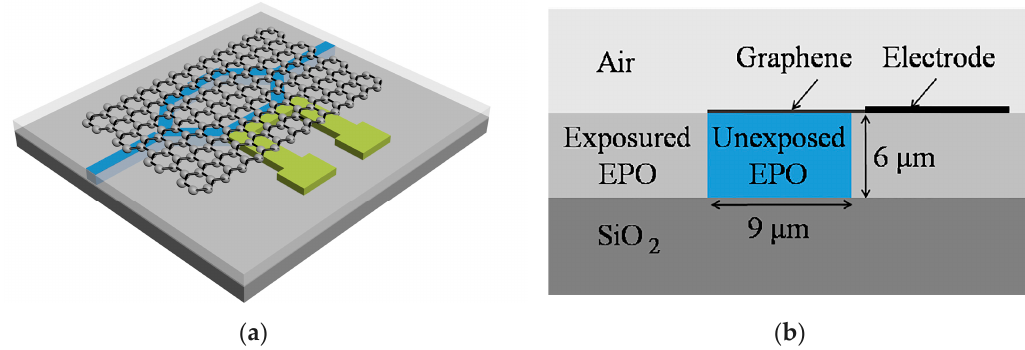
Figure 5. ( a ) The schematic of UV-writing thermal optical switch; ( b ) Schematic diagram of the cross-section of the device.